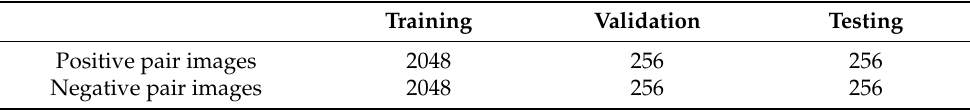
Table 6. Number of pairs of images used for training, validation, and test in the damage diagnosis model.